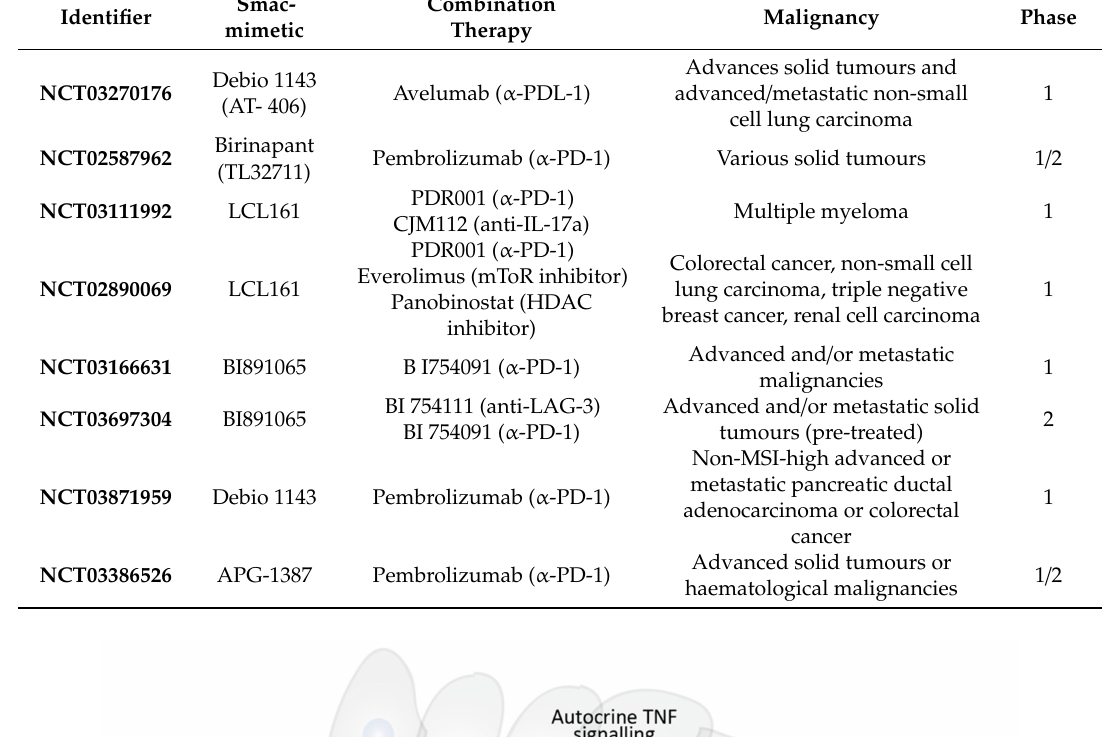
Table 1. Summary of smac-mimetics in clinical trials incorporating an immunotherapy approach.